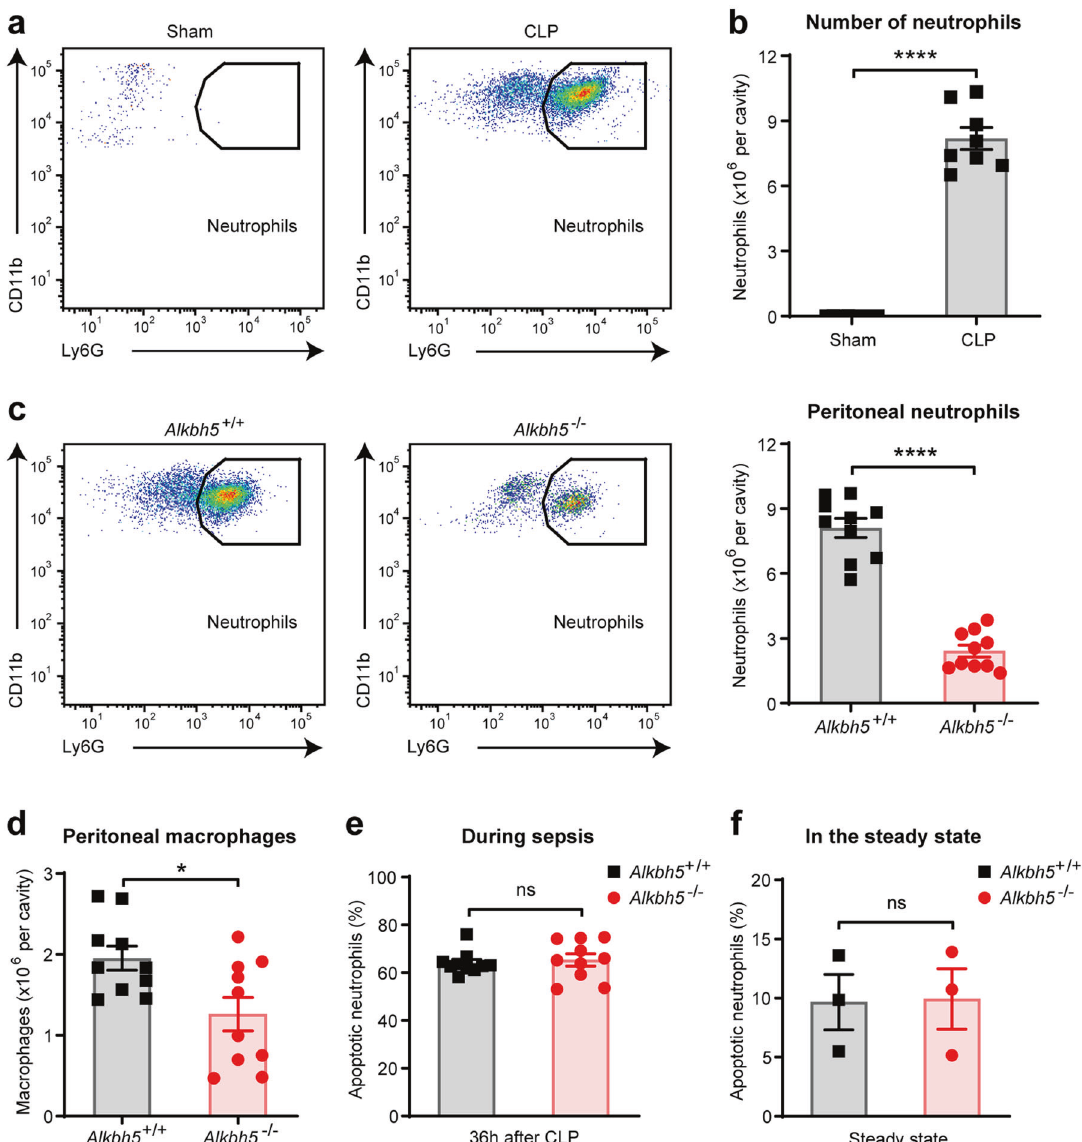
Fig. 2 ALKBH5 facilitates neutrophil accumulation in the site of infection in antibacterial defense. a FACS analysis of neutrophils in the peritoneal cavity of WT mice operated sham or mild CLP for 36 h. b Absolute numbers of peritoneal neutrophils from mice as in ( a ) ( n = 8). c FACS analysis of neutrophils in the peritoneal cavity of Alkbh5 -de fi cient mice and WT littermates at 36 h after mild CLP ( n = 10). d FACS analysis of macrophages in the peritoneal cavity of mice as in ( c ) ( n = 10). e FACS analysis of apoptotic neutrophils in the peritoneal cavity of mice as in ( c ) ( n = 10). f FACS analysis of apoptotic neutrophils in the bone marrow of Alkbh5 -de fi cient mice and WT littermates in the steady state ( n = 3). All data are mean ± SEM of biologically independent samples. Data are representative of 8 – 10 independent experiments